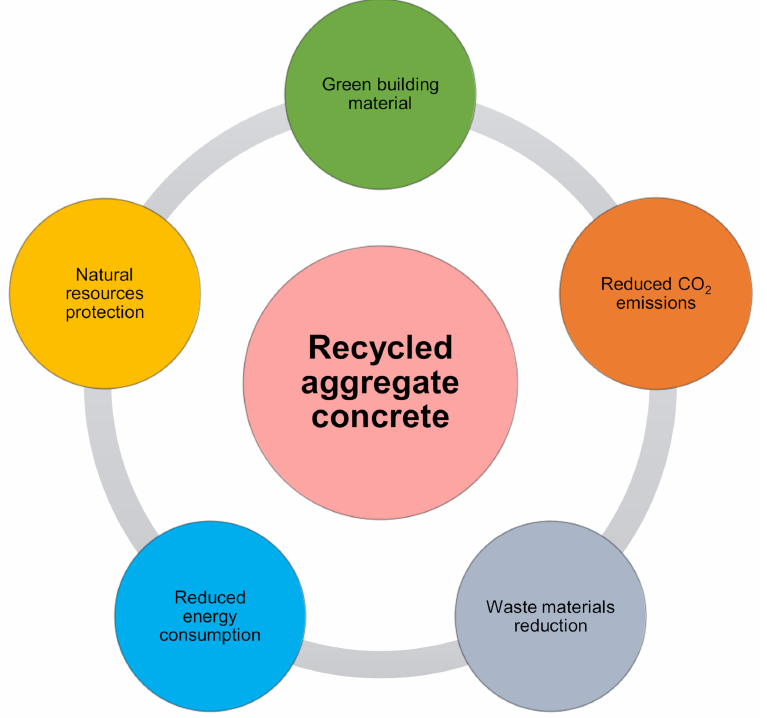
Figure 14. Benefits related to the adoption and application of recycled aggregate